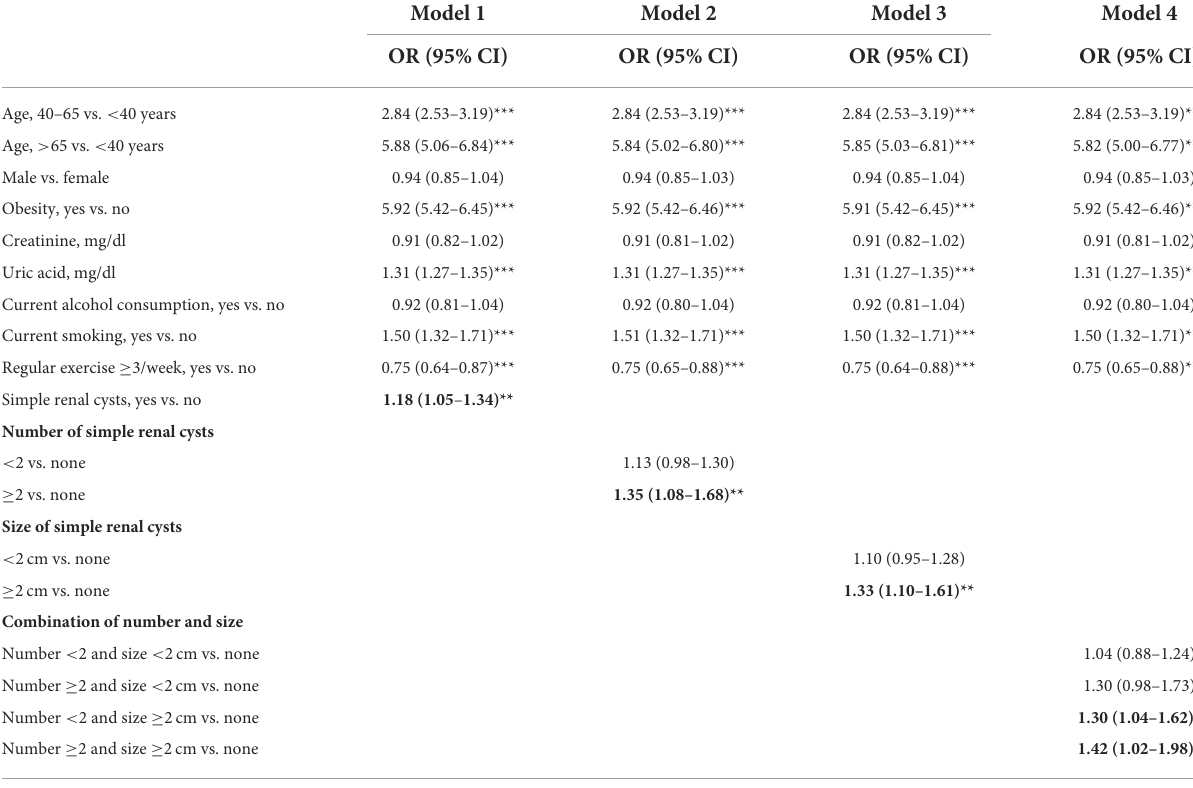
TABLE 3 Logistic regression models for the association of simple renal cysts with metabolic